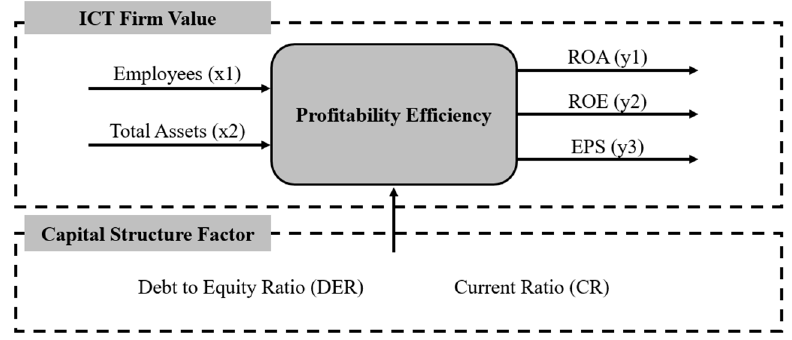
Figure 1. Profitability evaluation model.